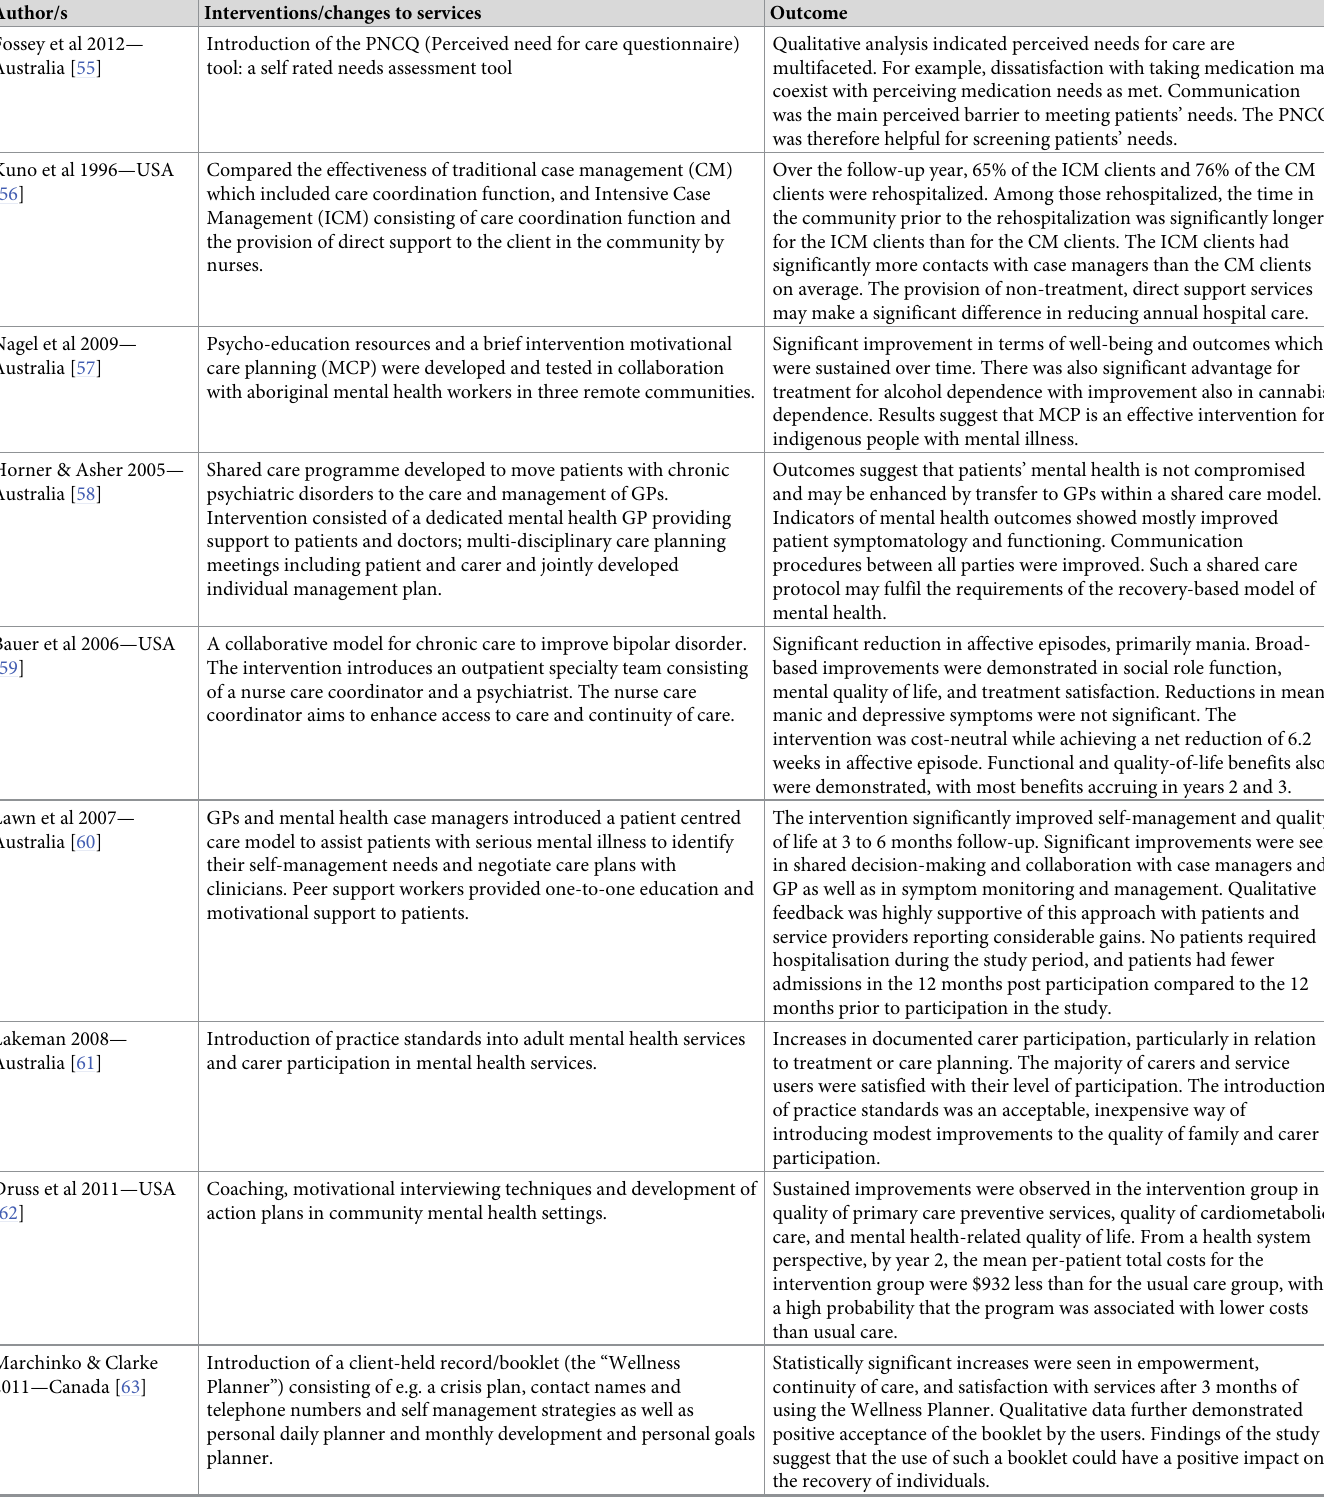
Table 4. Tradition 2: Interventions to improve care planning and coordination in the international